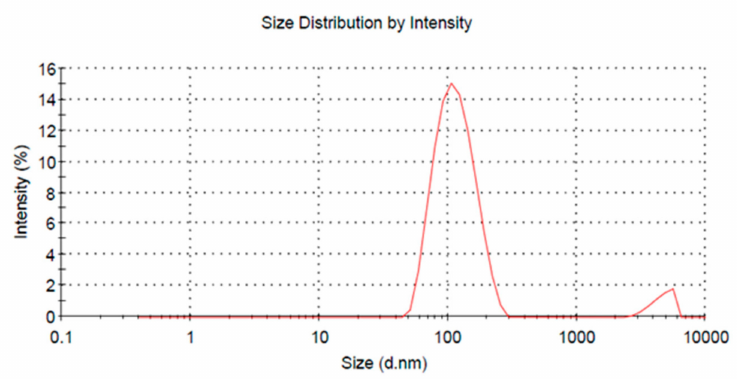
Figure 5. Graph of the VRIL23-chitosan nanoparticles size.